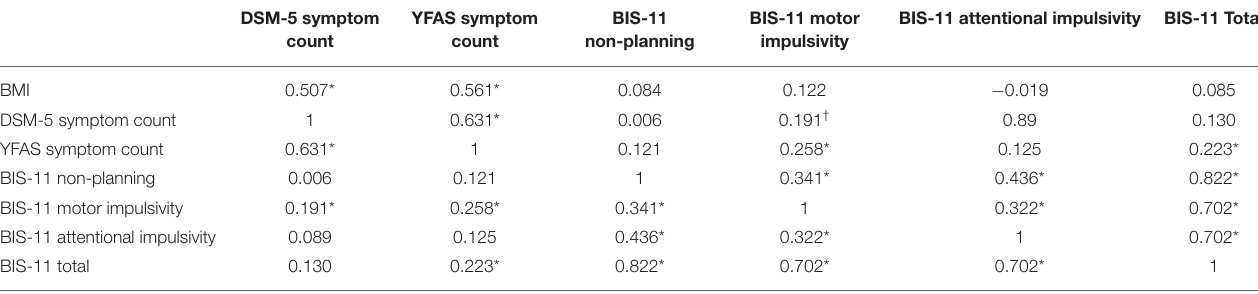
TABLE 4 | Correlation of BMI, FA symptom count, and BIS-11 scores.